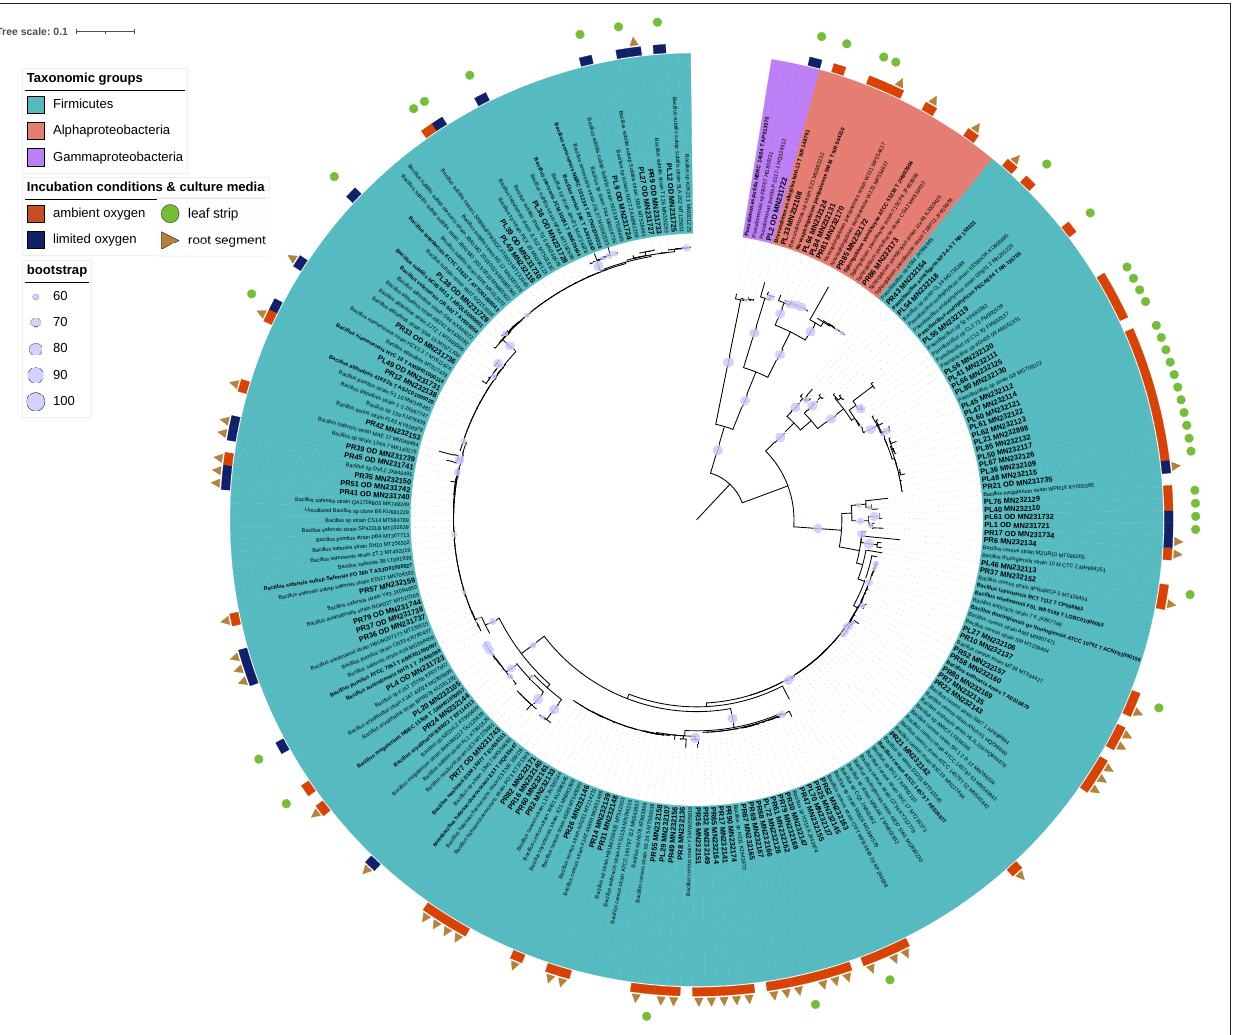
FIGURE 5 | Phylogenetic tree of 16S rRNA gene sequences of the 94 isolates representing endo-phyllosphere of sunflower plants. The colored labels indicate the taxonomic groups (Firmicutes, Alphaproteobacteria, Gammaproteobacteria), incubation conditions (ambient and limited oxygen), and culture media (leaf strips and root segments). Respective isolates identifier followed by their accession number are highlighted in bold and larger font style. In contrast, closely related strains are written in normal style, while type strains are displayed in bold, indicated by a T followed by the accession number. The phylogenetic tree was interfered with the Maximum Likelihood method under the GTRCAT model, using RAxML. The bootstrap values for 1,000 replicates are adorning the branches as